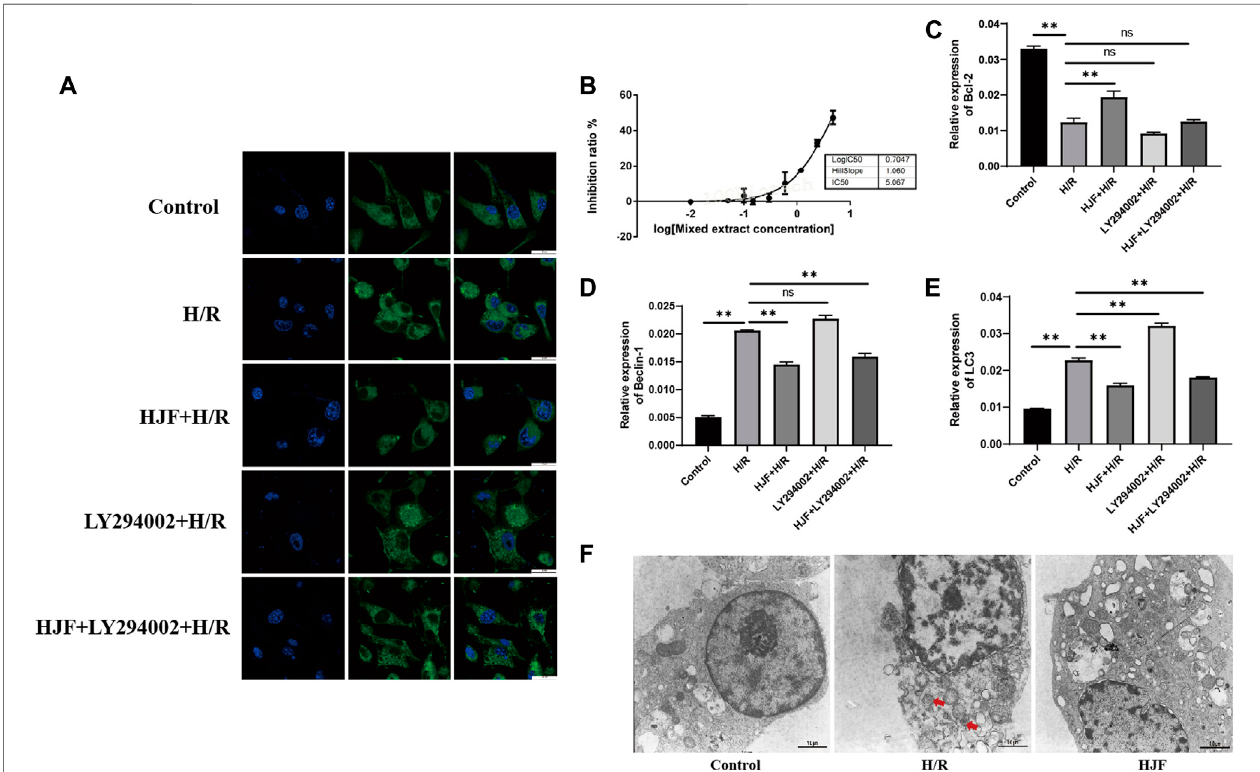
FIGURE 3 | Effects of HJF on H/R-induced autophagy in H9C2 cells. (A) , Images of LC3 under laser confocal microscopy with a scaleplate of 25 μ m (n (cid:1) 3); (B) , IC50 of HJF; (C) , mRNA expression of Bcl-1 (n (cid:1) 6); (D) , mRNA expression of Beclin-1 (n (cid:1) 6); (E) , mRNA expression of LC3 (n (cid:1) 6); (F) , Autophagosome formation observed by transmission electron microscopy with a scaleplate of 1 μ m (marked with blue arrow) (n (cid:1) 3). The data are shown as the means ± SDs in each group. * p < 0.05, ** p < 0.01. H/R, Hypoxia/reoxygenation; HJF, Huoxue Jiedu Formula.